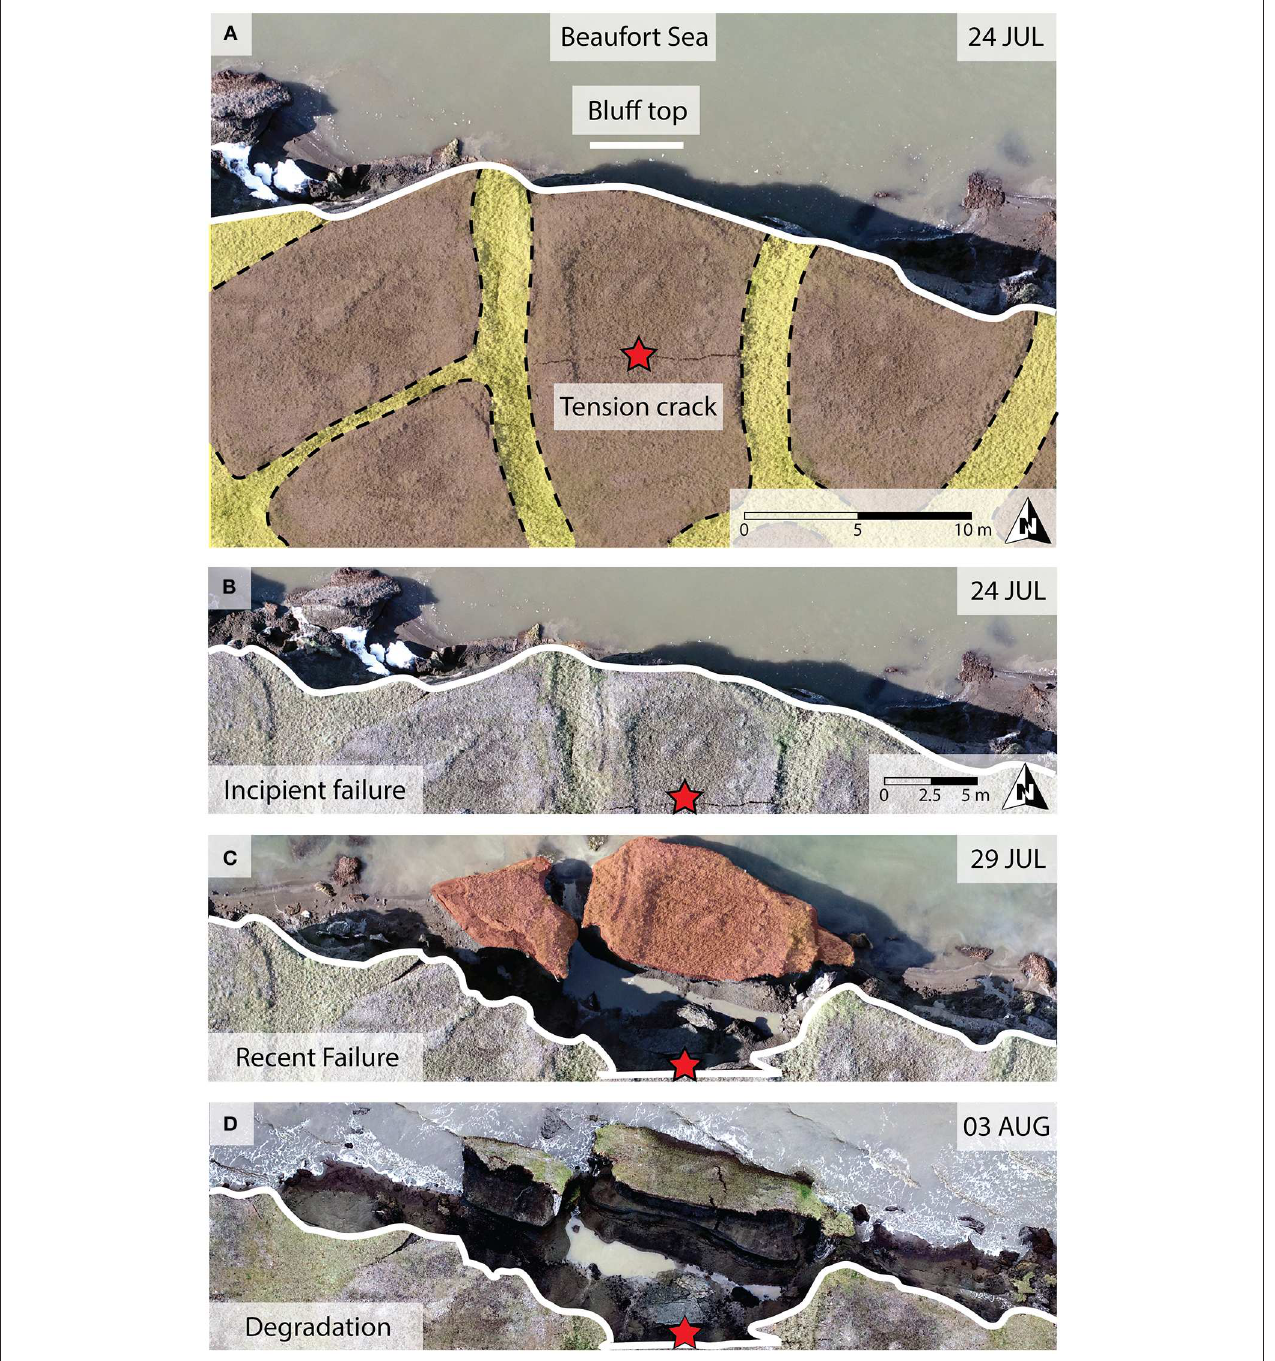
FIGURE 2 | (A) Unmanned aerial vehicle (UAV)-based orthophoto mosaic of a tension crack (red star) visible on 24 July 2018. The local bluff height, niche height, and niche depth are approximately 4.9, 1.9, and 4.5m, respectively. Yellow and brown shaded areas highlight ice wedges and polygon centers, respectively. Sequence of repeat UAV-based orthophoto mosaics showing (B) incipient failure (24 July), (C) recent failure (29 July), and (D) degradation of the permafrost block in the nearshore environment (03 August).